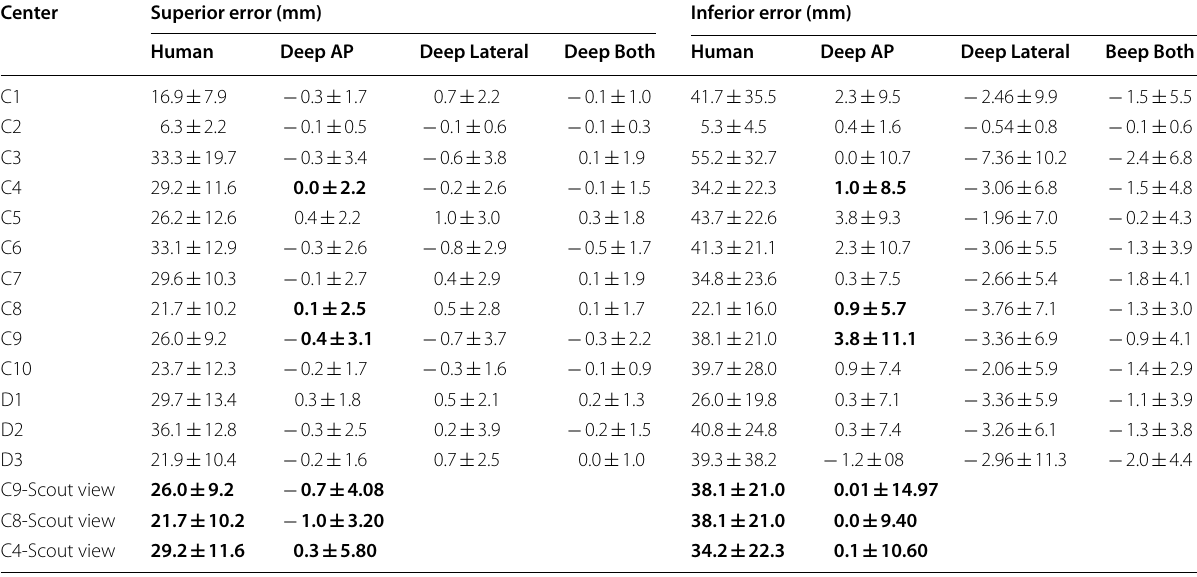
The bolded cells reflect the results of delimitation by means of AP projections for the same centers where APscout-views The negative values indicate missing the lung, whereas the positive values indicate overscanning. The last row is for the results of fine-tuning the network on AP scout-view images for center C9